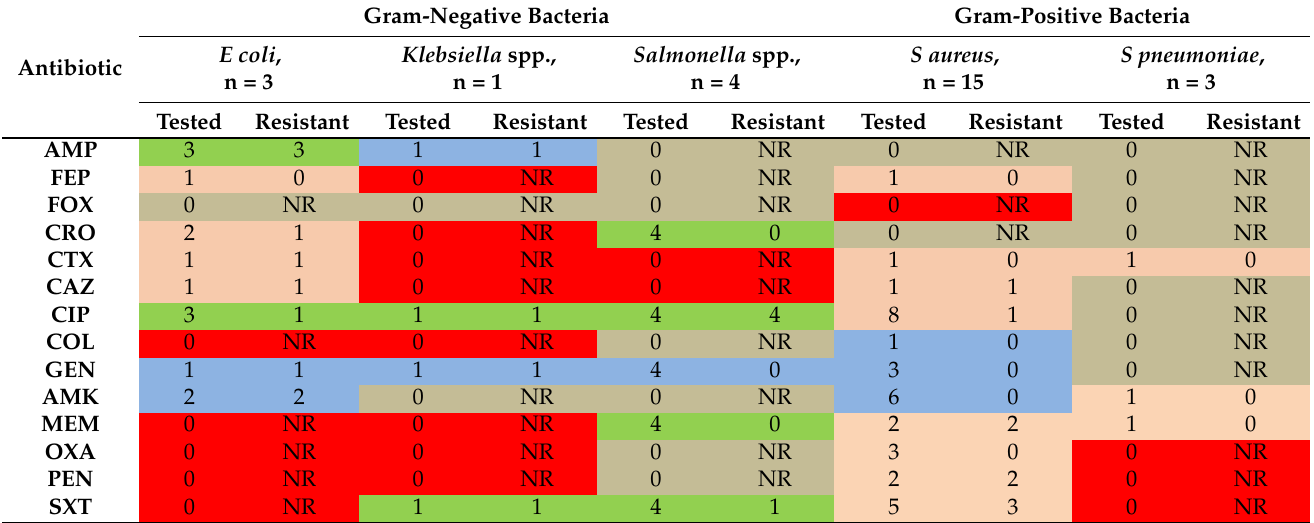
Table 4. Compliance with antimicrobial susceptibility testing guidelines and resistance patterns of identified AMR surveil- lance priority pathogens among hospitalized, non-malarial febrile children undergoing blood culture at five AMR surveil- lance sites in Uganda, October 2017–September 2018. Gram-Negative Antibiotic